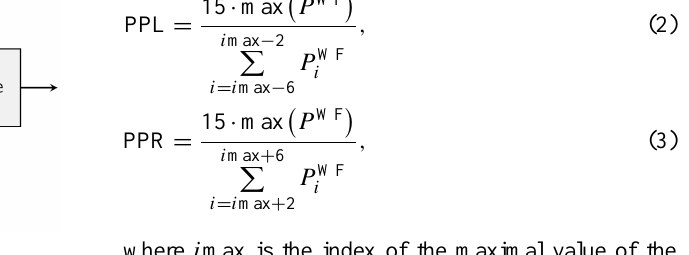
Figure 3. Flow chart of the cross-validation scheme used.